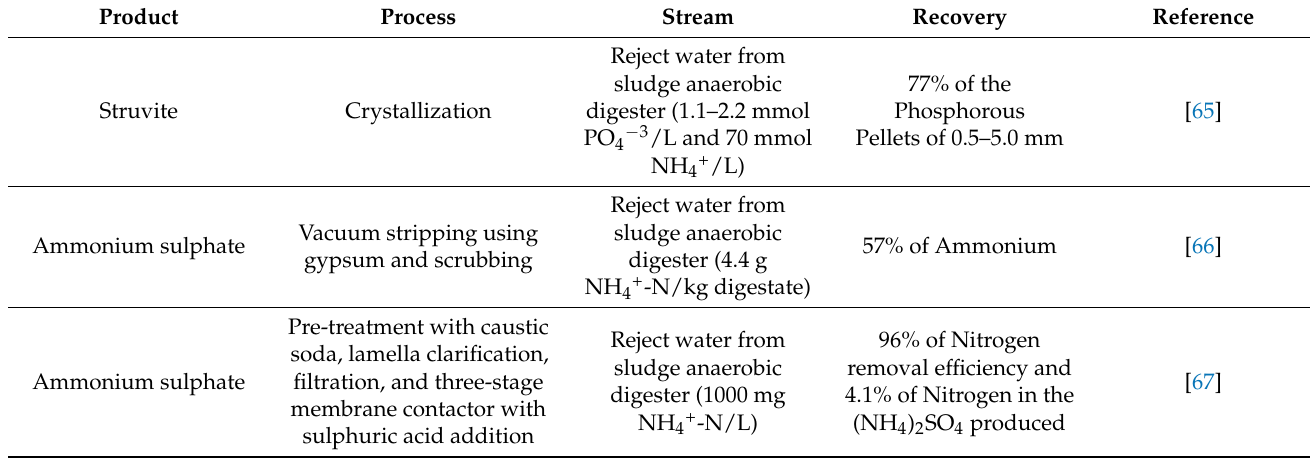
Table 6. Nutrient and fertilizer recovery as valuable products from different kinds of wastewater at full-scale processes.